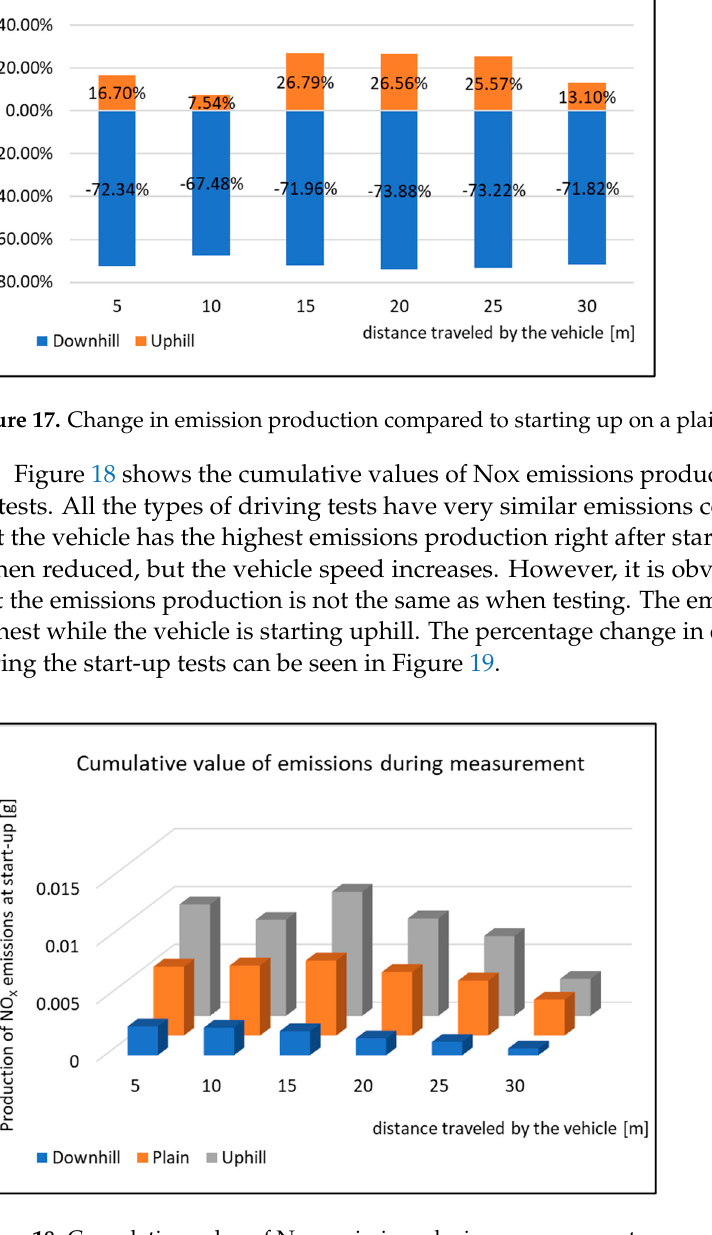
Figure 19. Change in emission production compared to starting up on plain. The graph in Figure 19 displays the percentage difference of change in the emissions production compared to the vehicle starting on level ground. When starting uphill, the highest change was from the distance of 15 m. From this distance, the emissions produc- tion increased by almost 54% compared to the start-up tests on level ground. However, when driving 30 m, the emissions production was reduced and its value increased only by 3%. The opposite occurred when starting downhill. Here, the Nox emissions decreased on average by 69% compared to starting on level ground. Due to this fact, it can be said that the vehicle starting downhill is the least burdensome for the environment with re- gards to emissions production. 4. Discussion Nowadays, many vehicle owners are very much interested in reducing fuel con- sumption. The study results of Levin et al. [45] show that if drivers do not consider the